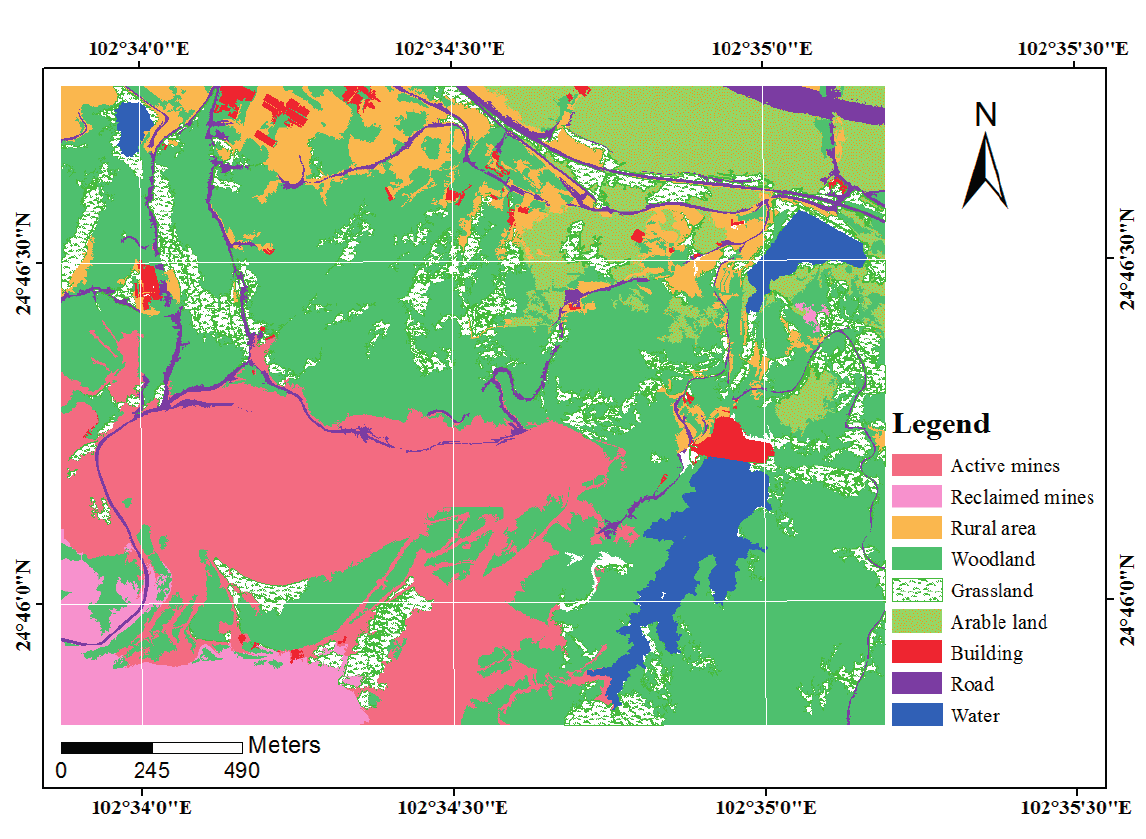
Figure 9. Result of the classification of land covers in the Jianshan area.